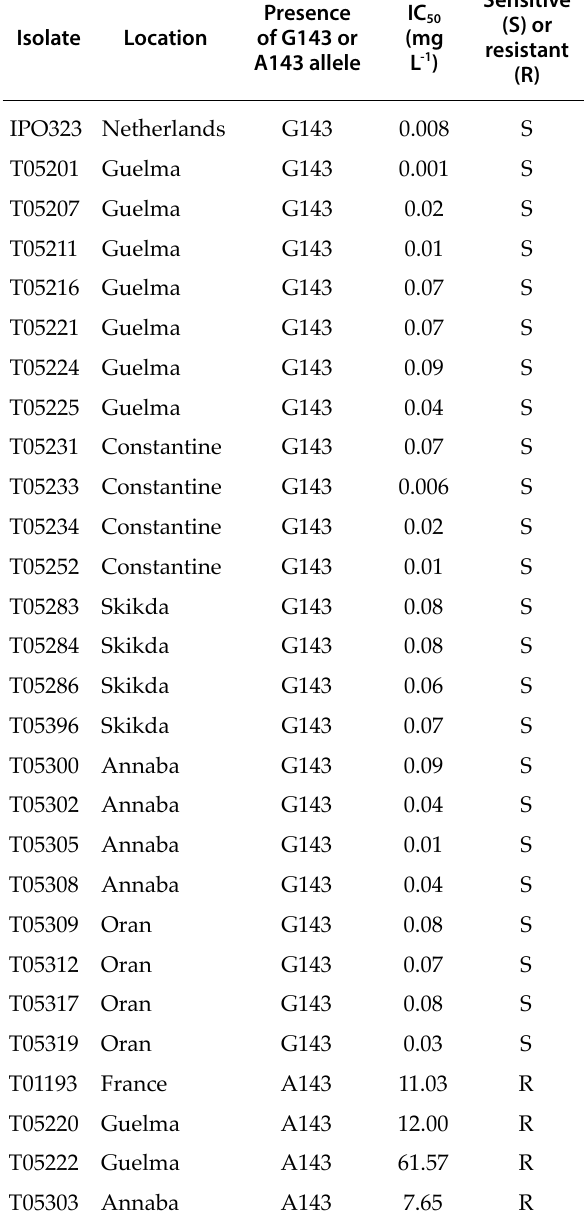
Table 3. Half maximal azoxystrobin inhibitory concentra- tion (IC 50 ) values for 26 Algerian and two European refer- ence Zymoseptoria tritici isolates, established from micro- plate bioassays.